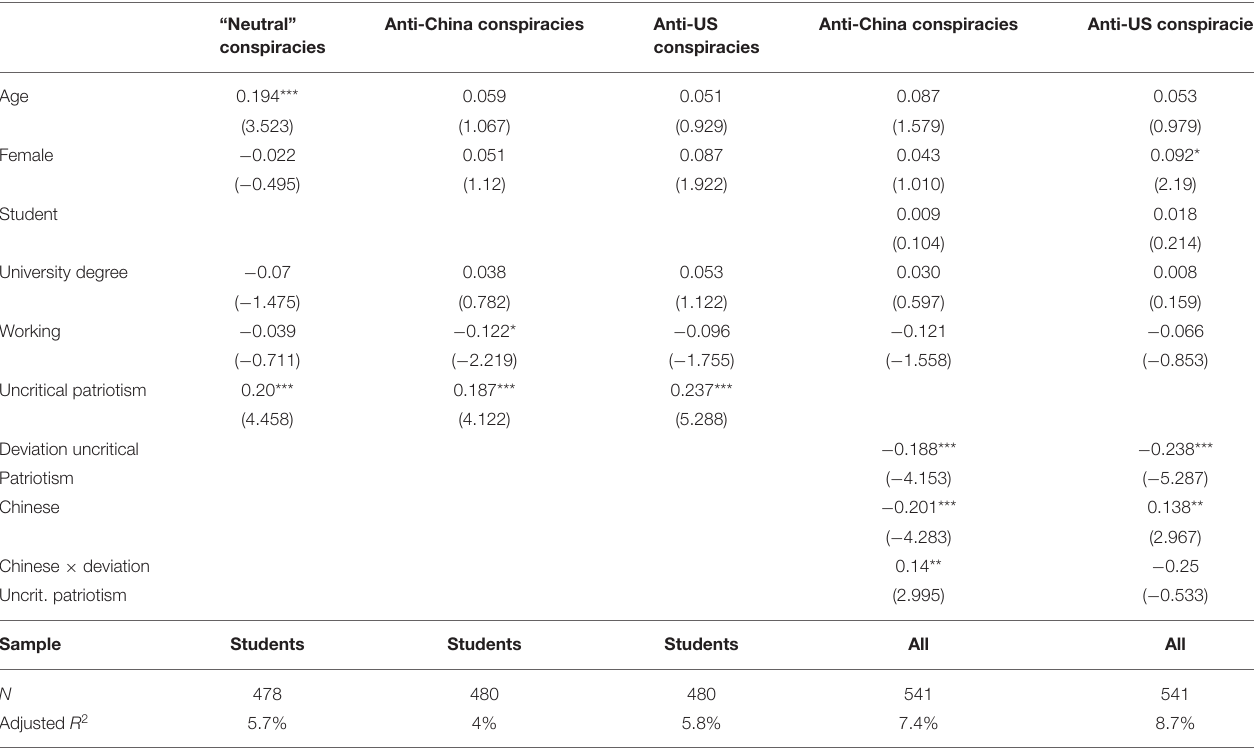
TABLE 5 | Effect of uncritical patriotism on belief in conspiracy theories among Germans and Chinese living in